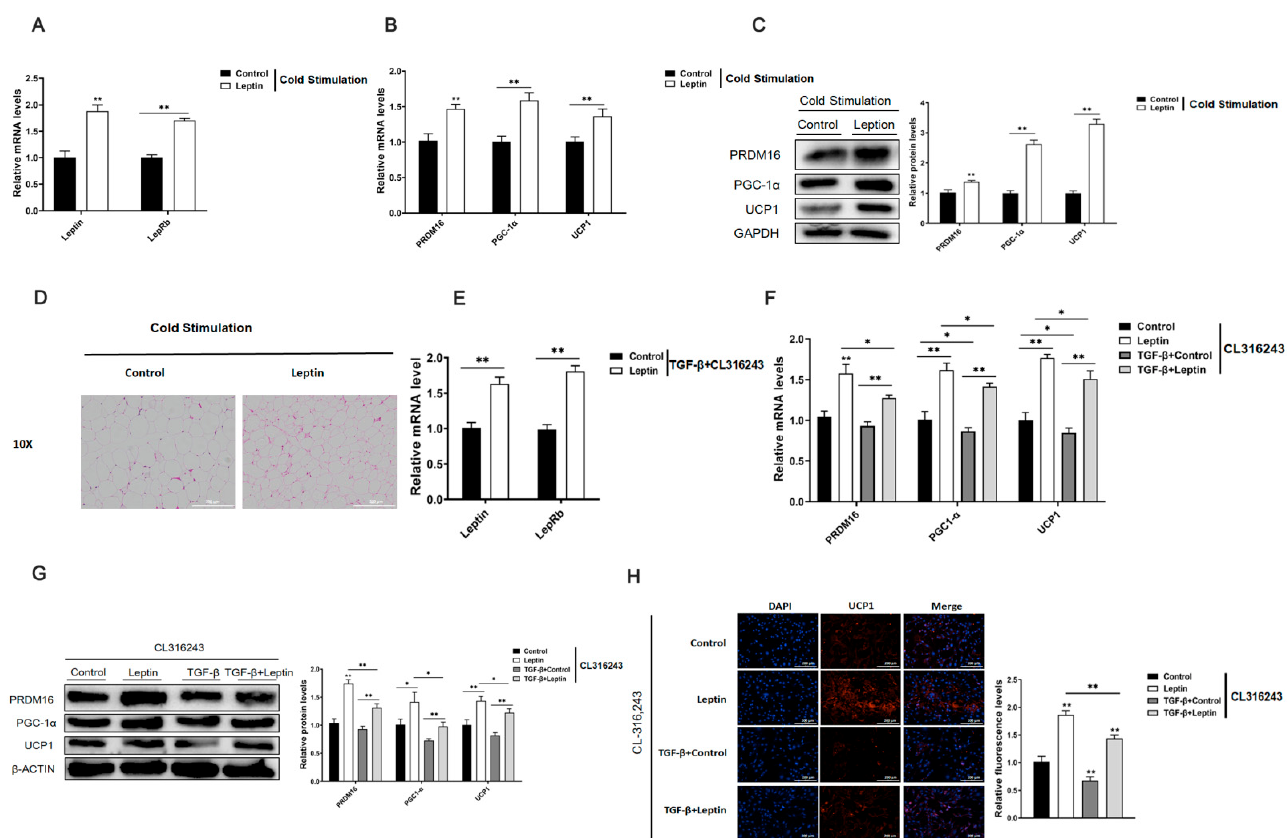
Figure 5. Leptin promotes browning of fat tissues and improves the inhibitory effect of TGF- β on browning of adipocyte. Eight-week-old C57BL/6J mice were injected with leptin for 7 d and exposed to a cold environment at 4 °C for 24 h. After the mice were sacrificed in the neck, the total RNA and protein of the inguinal adipose tissue were extracted. ( A ) The relative mRNA expression levels of leptin and its receptor ( n = 4). ( B , C ) The relative mRNA and protein expression levels of adipose tissue browning-related genes PRDM16, PGC-1 α , UCP1 ( n = 4). ( D ) HE staining of adipose tissue section, scale bar: 200 μ m ( n = 4). We used TGF- β to build a cell fibrosis model, and, under the conditions, treated with leptin, and then treated with an adrenergic receptor agonist (CL316, 243) to induce browning of adipocytes. ( E ) The relative mRNA expression levels of leptin and its receptor ( n = 4). ( F , G ) The relative mRNA and protein expression levels of adipocyte browning-related genes PRDM16, PGC-1 α , UCP1 ( n = 4). ( H ) Immunofluorescence staining of UCP1, scale bar: 200 μ m ( n = 4). Values are means ± SD, * p < 0.05, ** p < 0.01 compared with the control group.